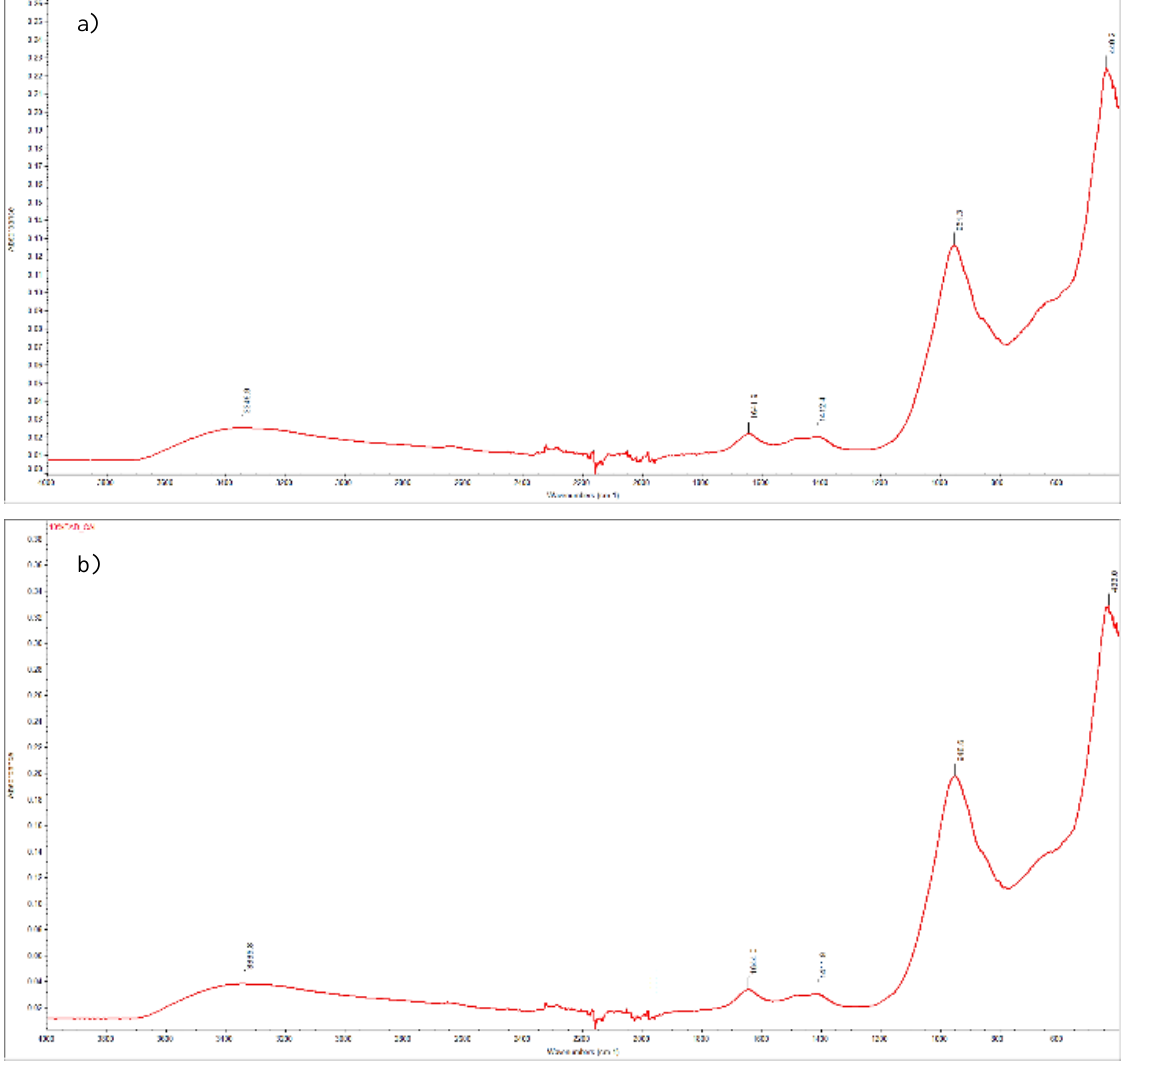
Figure 4. The result of FTIR using a) 10 % FA b) 10 %